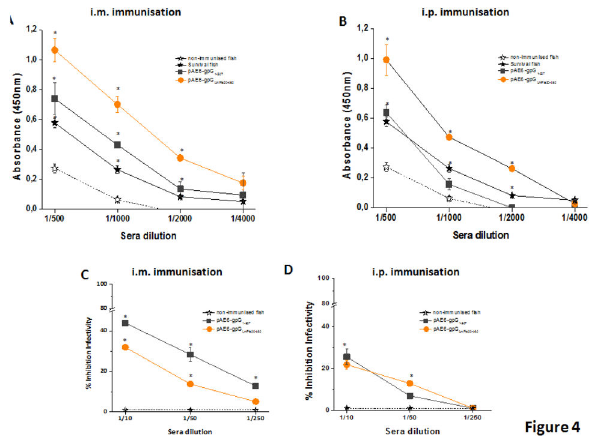
Figure 4. Specific IgMs anti-VHSV-gpG (A and B) and neutralizing activity in sera from immunised trout (C and D). The presence of specific antibodies against VHSV-gpG in trout sera was determined 30 days post-vaccination by an enzyme-linked immunosorbant assay (ELISA). Sera obtained from VHSV-survivor trout was used as a positive control. Absorbance readings were measured at 450 nm. Results represent the average values and standard deviations of sera from four fish per group, each assay in triplicate, from two different experiments where (A), is sera from fish immunised i.m. and (B), from fish immunised i.p. Neutralising assay from sera from fish immunised i.m. (C) or i.p.(D); VHSV was incubated with increased dilutions of sera from immunised or 07.71 control trout as described in materials and methods. EPC cell monolayers were then infected with VHSV for 2h at 14 °C. Twenty four hours post-infection, the number of focus of VHSV were estimated as described in the material and methods section. 07.71 Results were expressed as inhibition percentage relative to cells infected with untreated virus as calculated by the formula (100 − (number of DAB positive foci in EPC cultures treated with trout serum, complement and VHSV /number of DAB positive foci in 07.71 EPC cultures treated with trout serum and VHSV in the absence of complement) × 100). Symbols represent the average values 07.71 and standard deviations (error bars) of two independent experiments each performed in duplicate. The sera dilution marked with “*” showed statistically significant differences with control fish at p< 0.05 according to the